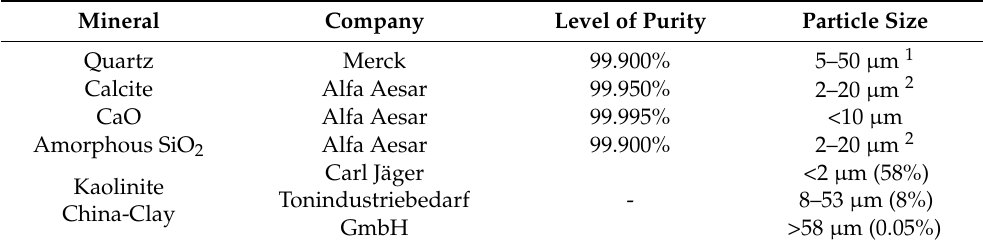
Table 1. Characteristics of the precursor material used for experiment E2 and